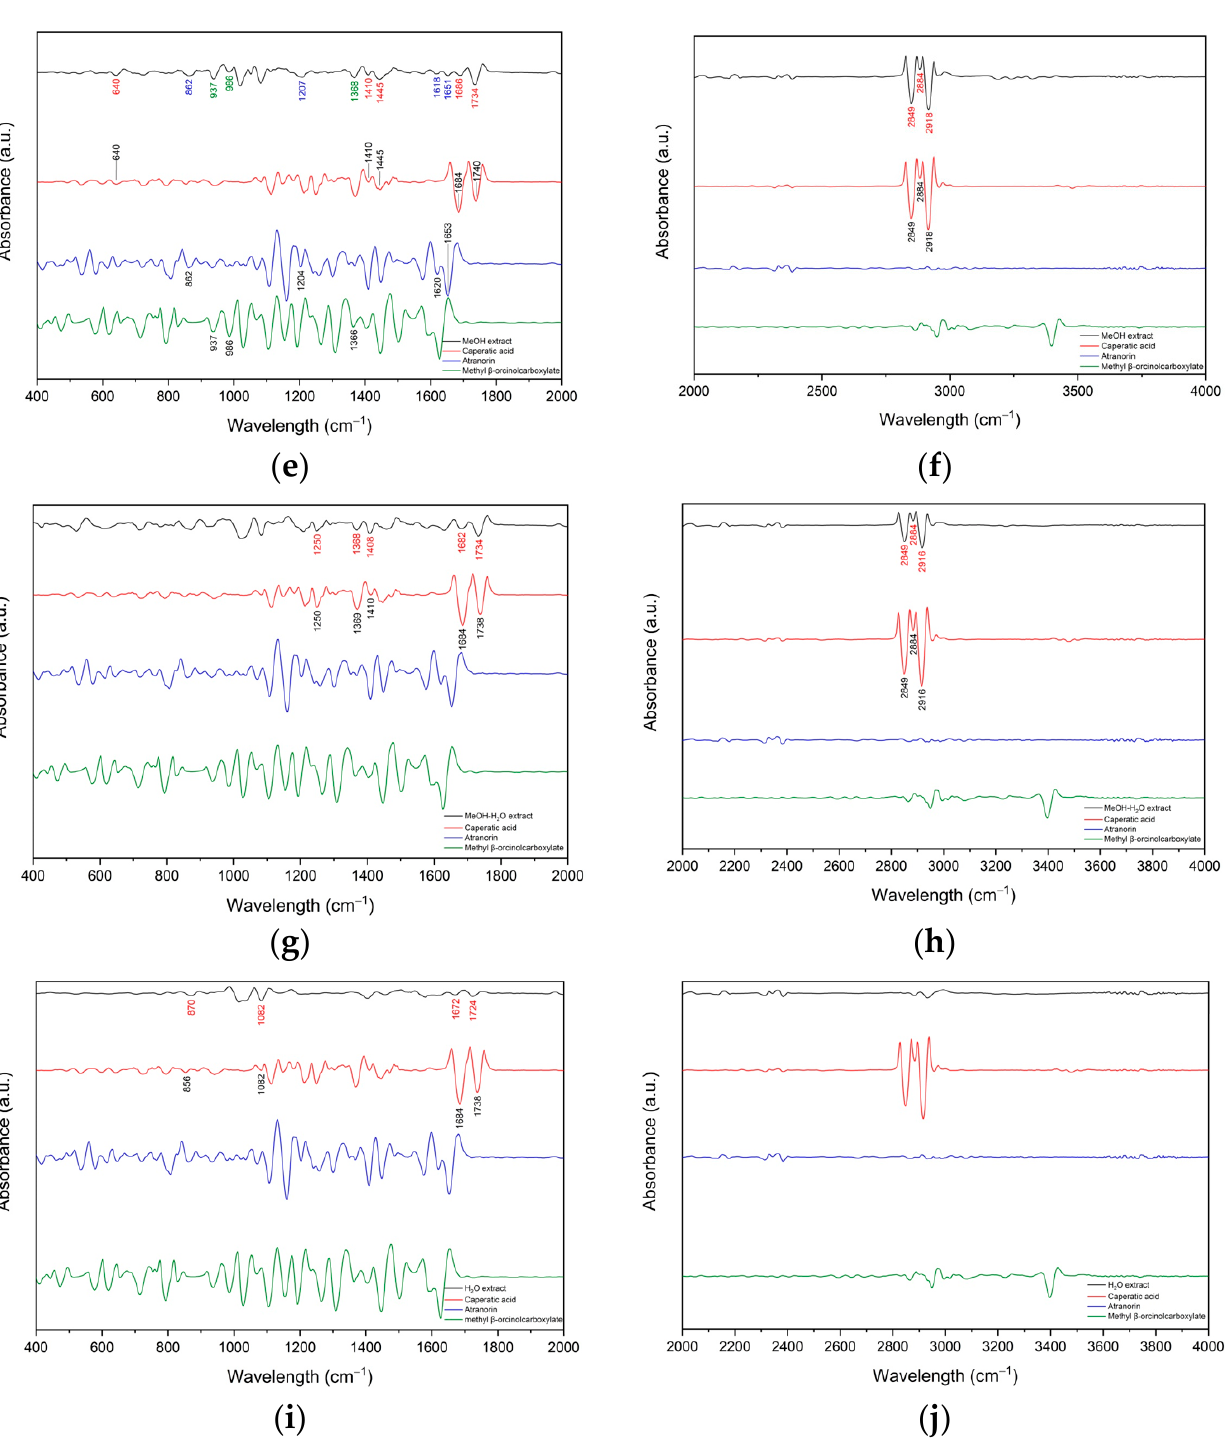
Figure 2. Second derivative infrared spectra (by the Savitzky–Golay polynomial fitting method, 25-point smoothing) of DCM extract range 400–2000 cm − 1 ( a ), DCM extract range 2000–4000 cm − 1 ( b ), Ace extract range 400–2000 cm − 1 ( c ), Ace extract range 2000–4000 cm − 1 ( d ), MeOH extract range 400– 2000 cm − 1 ( e ), MeOH extract range 2000–4000 cm − 1 ( f ), MeOH-H 2 O extract range 400–2000 cm − 1 ( g ), MeOH-H 2 O extract range 2000–4000 cm − 1 ( h ), H 2 O extract range 400–2000 cm − 1 ( i ), H 2 O extract range 2000–4000 cm − 1 ( j ); (black line) juxtaposed with the spectra of caperatic acid (red line), atranorin (blue line) and methyl β -orcinolcarboxylate (green line).